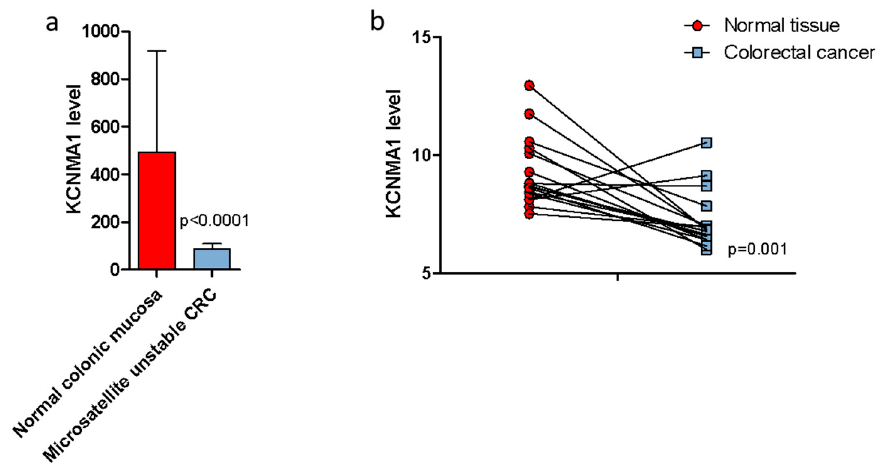
Figure 2. KCNMA1 expression is modulated in colorectal cancer (CRC). ( a ) KCNMA1 levels were determined in colonic mucosa of healthy subjects ( n = 15) and in patients with microsatellite unstable CRC ( n = 34); ( b ) and on neoplastic and normal tissue of each patient ( n = 17). Unpaired ( a ) and paired ( b ) two-tailed Student’s T test was applied to assess statistical differences between groups.